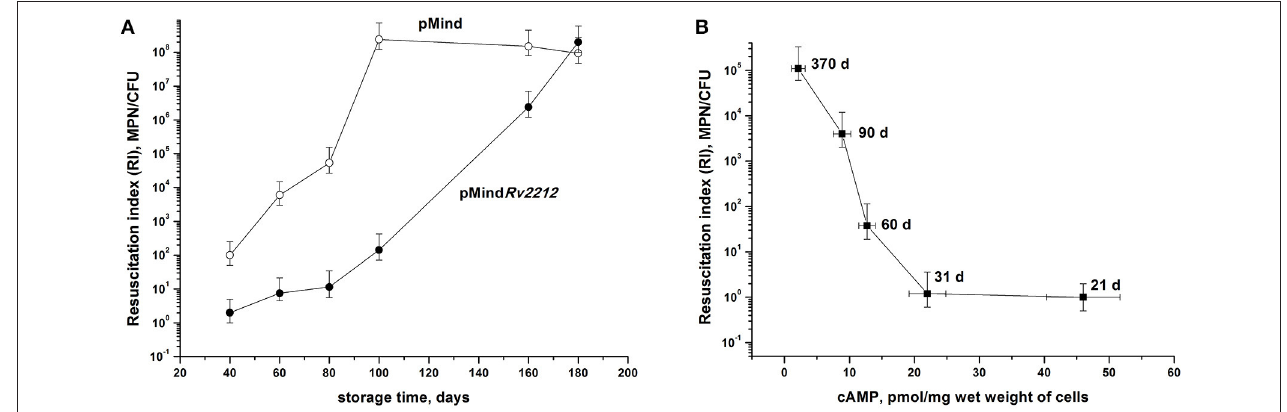
FIGURE 3 | Development of “non-culturability” (A) and cAMP content (B) of M. tuberculosis during dormant bacteria storage. (A) M. tuberculosis pMind Rv2212 (closed circles) or pMind (open circles) developed in the “glycerol” modified Sauton’s medium were kept statically at the room temperature. Periodically, samples were collected for RI estimation. (B) The wild type mycobacteria were grown and kept under identical conditions for monitoring cAMP intracellular concentrations and RI estimation. Sampling days are indicated. Experiment shown in (A) was repeated twice, one representative experiment is shown. Results shown in (B) display the average from three independent experiments.